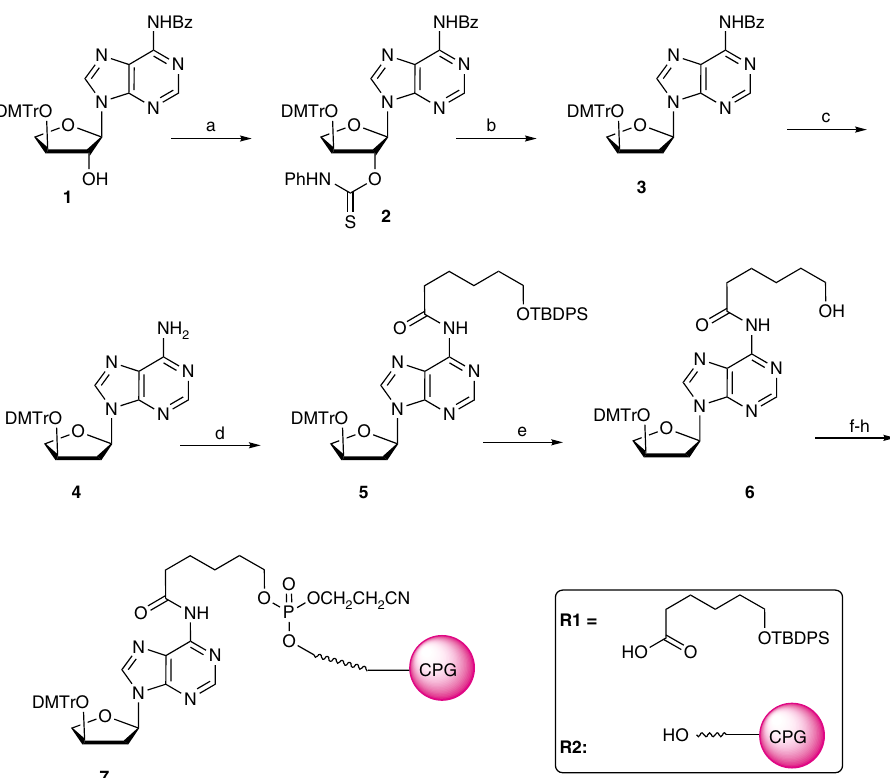
Fig. 2 Chemical synthesis scheme of 2 ′ -deoxy- α - L -threofuranosyl adenosine-modi fi ed CPG (Compound 7). Reagents: a PhNCS, NaH, THF, rt, 2.5 h, 80%; b AIBN, Bu 3 SnH, toluene, 100 °C, 45 m, 86%; c K 2 CO 3 , MeOH, 72%; d R1 , PyBOP, DIPEA, DCE, 43%; e TBAF/THF, 70%; f 2-cyanoethyl- N,N - diisopropylchlorophosphoramidite, DIPEA, DCM; g R2 , EtS-tetrazole, MeCN; h I 2